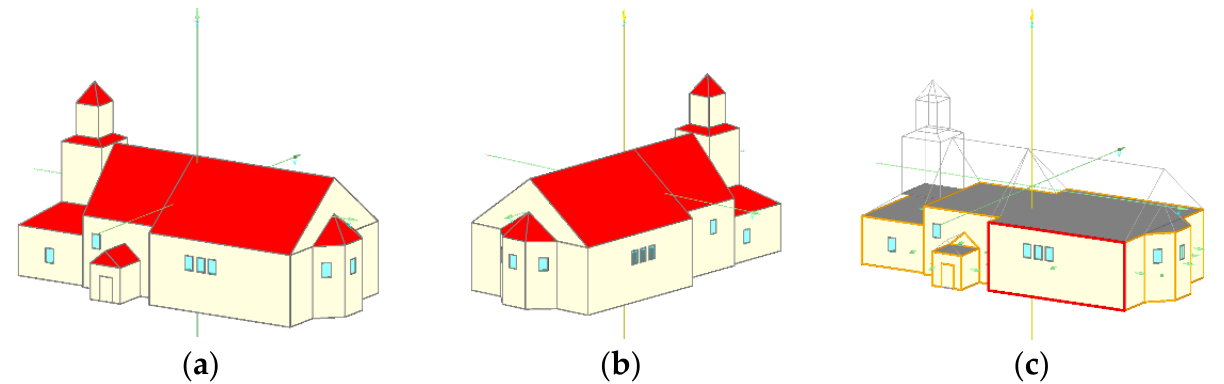
Figure 3. Geometric model of the church, built inWUFIplus ® ver. 3.2.0.023 software (Fraunhofer Institut fur Bauphysik, Holzkirchen Branch, Germany): ( a )—south-east orientation; ( b )—north-east orientation; ( c )—heating zone, beneath attached zone (unheated).